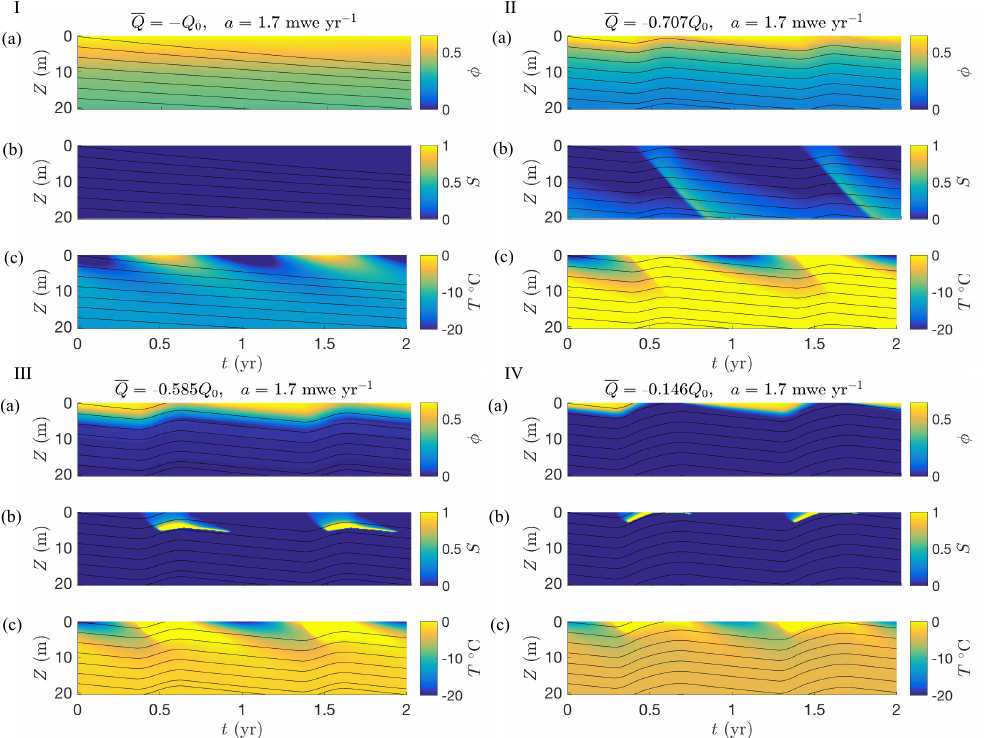
Figure 6. Space–time diagrams showing the evolution of porosity φ (a) , saturation S (b) , and temperature T (c) as a function of time for the accumulation rate a = 1 . 7mw.e.yr − 1 and four values of forcing: (I) cold accumulation zone where the mean forcing is Q = − Q 0 and (II) accumulation area with mean forcing Q = − 0 . 707 Q 0 . In this case, a clear perennial aquifer develops. (III) Accumulation area with larger forcing Q = − 0 . 575 Q 0 . (IV) Ablation zone with mean forcing Q = − 0 . 146 Q 0 . In all simulations the porosity of the falling snow is φ 0 = 0 . 64 and the black lines show ice streamlines.